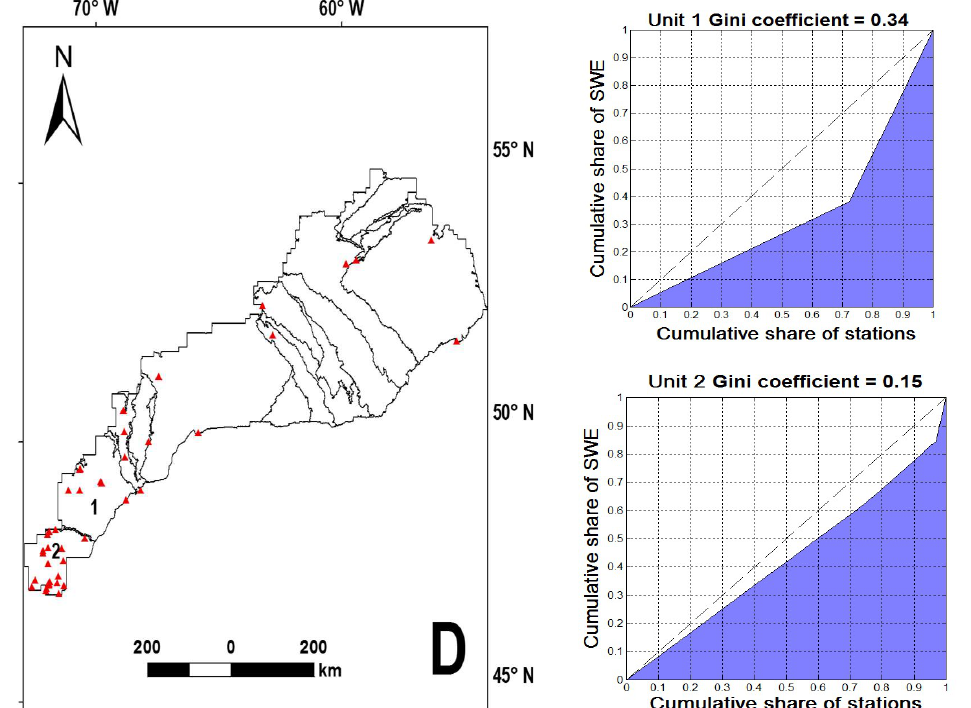
Figure 8. Lorenz curves and values of spatial distribution unevenness of stations in the units of zone B, at the local scale.